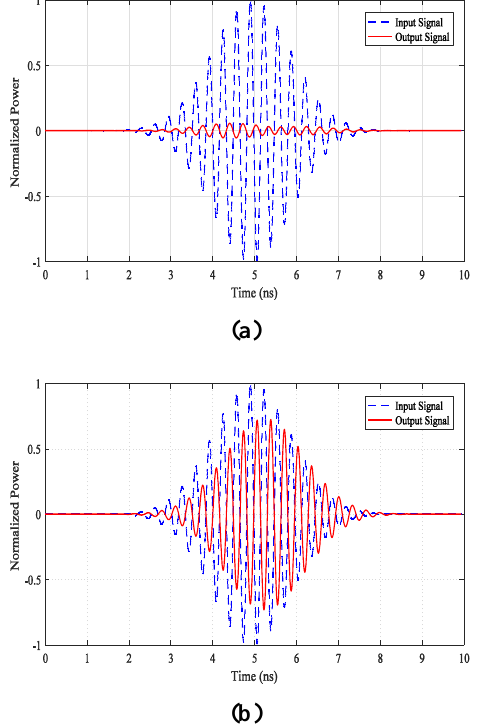
Figure 6: Time domain response of the structure to an RF Gaussian pulse input signal at two reflection (a) and transmission (b) states.